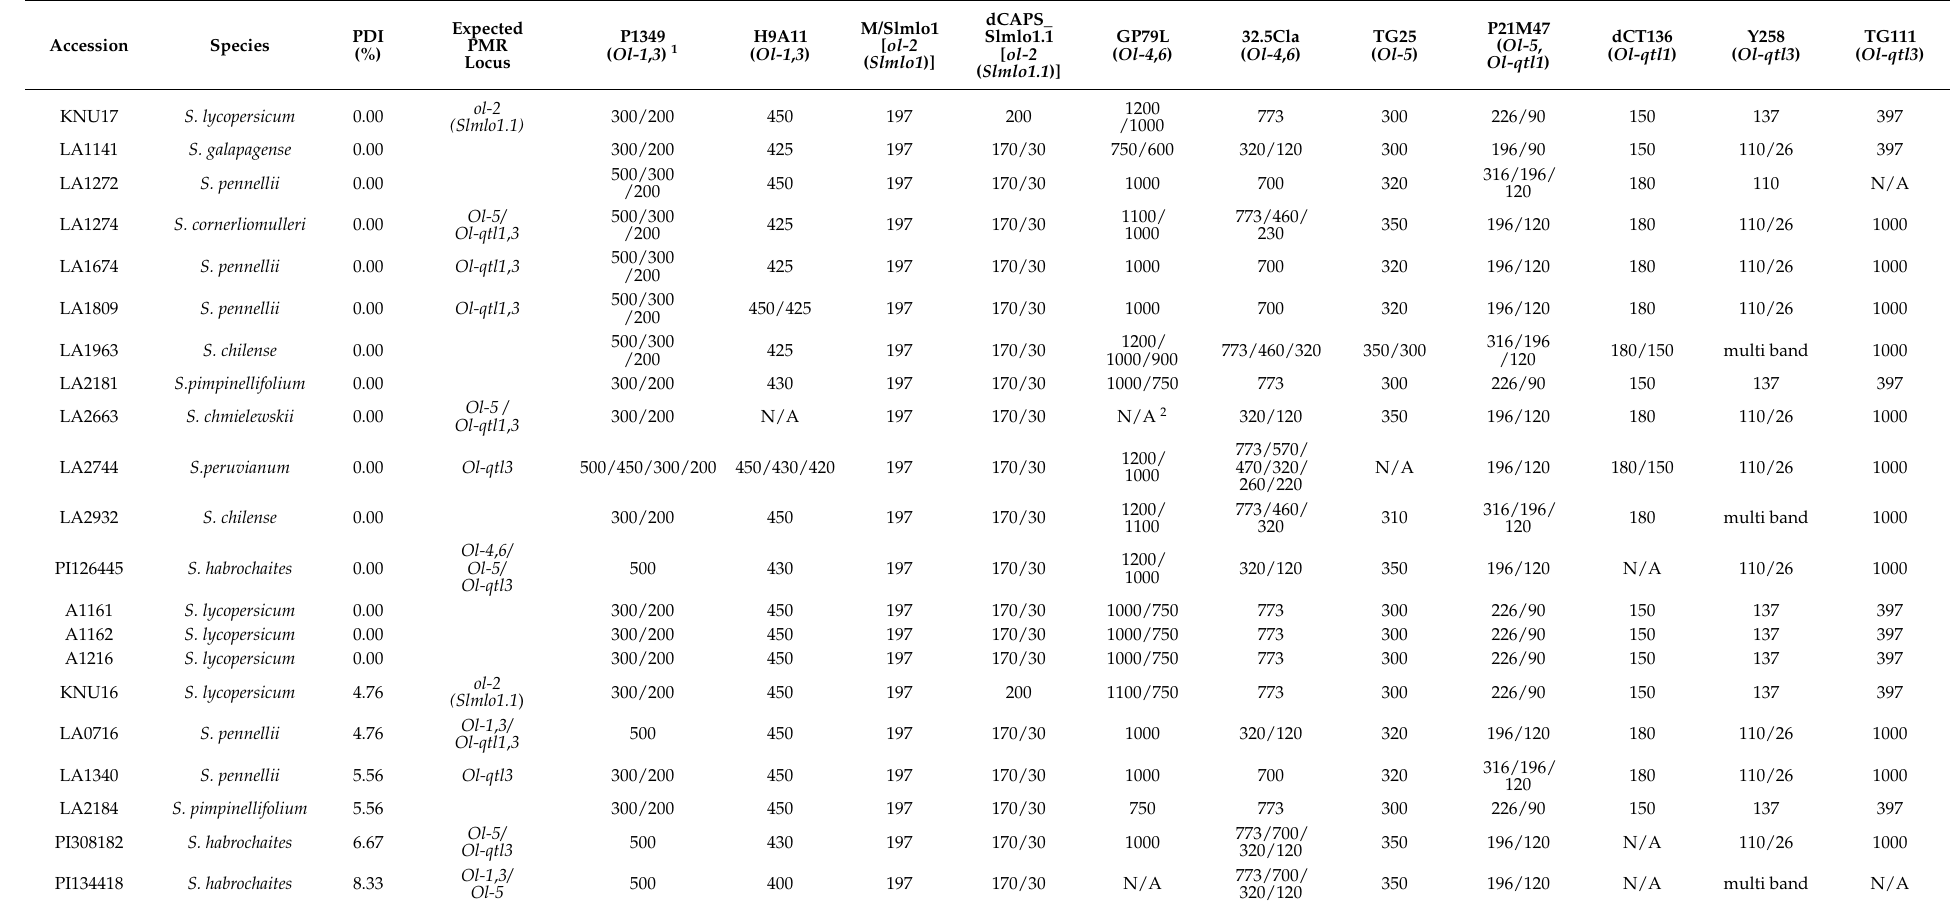
Table 1. Results of genotyping for powdery mildew resistance (PMR) markers in powdery mildew-resistant tomato accessions, and their PMR genes inferred based on the marker